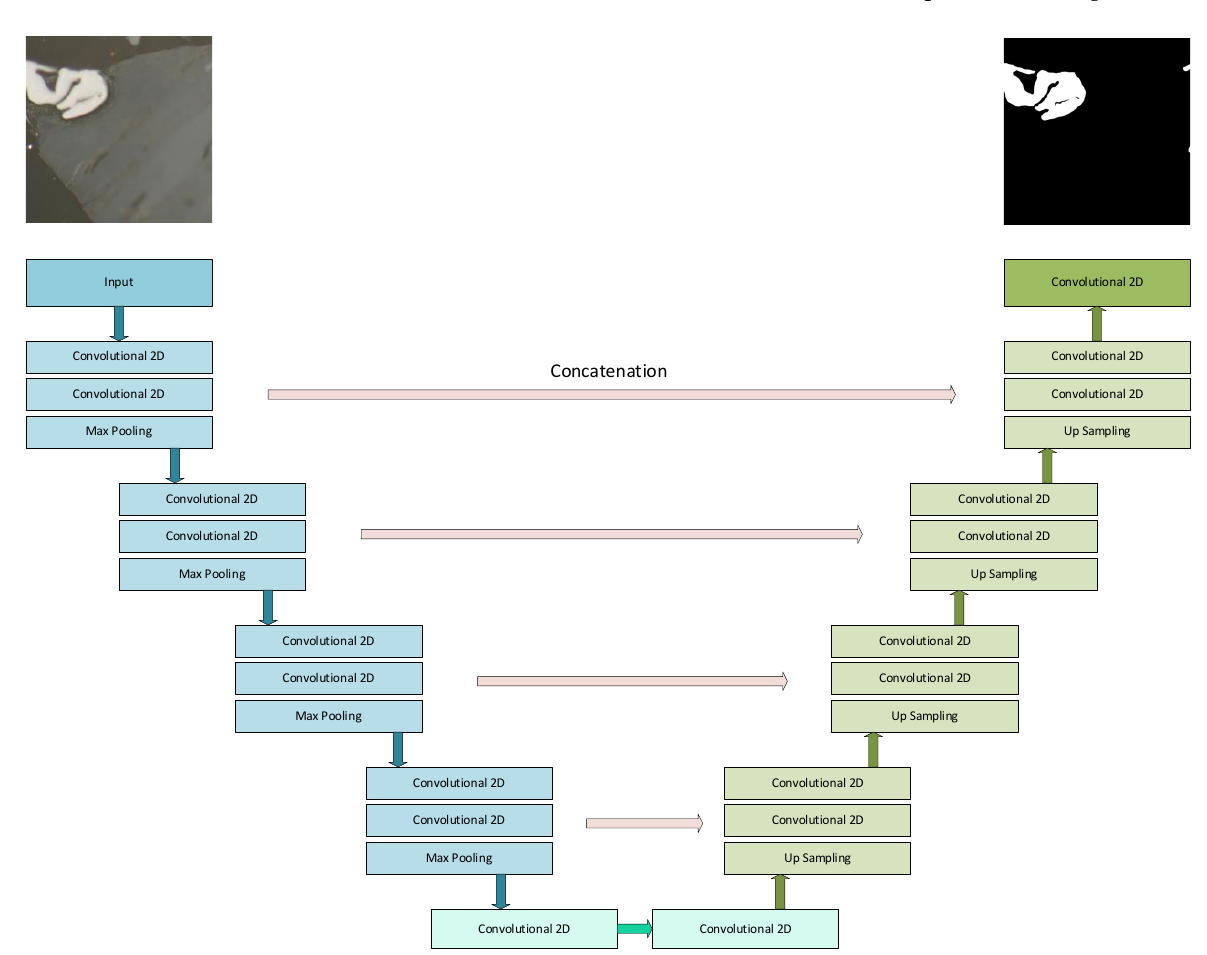
Figure 5. The architecture of U-Net network [71].